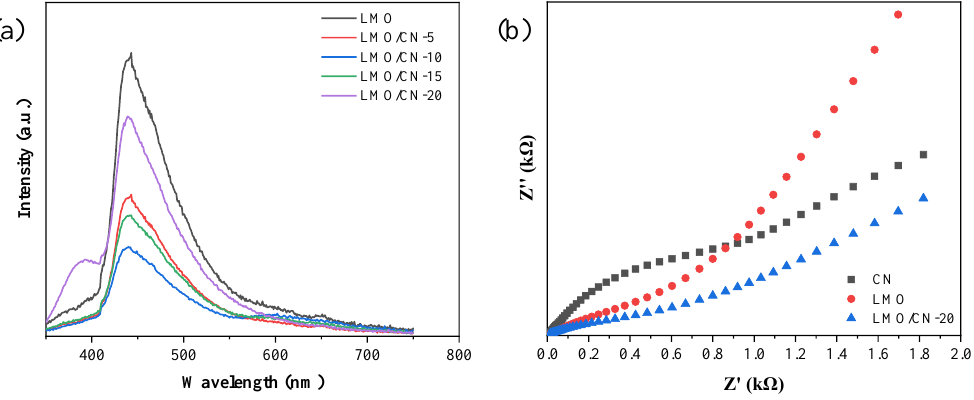
Figure 5. PL of LMO, LMO/CN-x (x = 5, 10, 15, 20) ( a ) and EIS of CN, LMO, LMO/CN-10 ( b ).